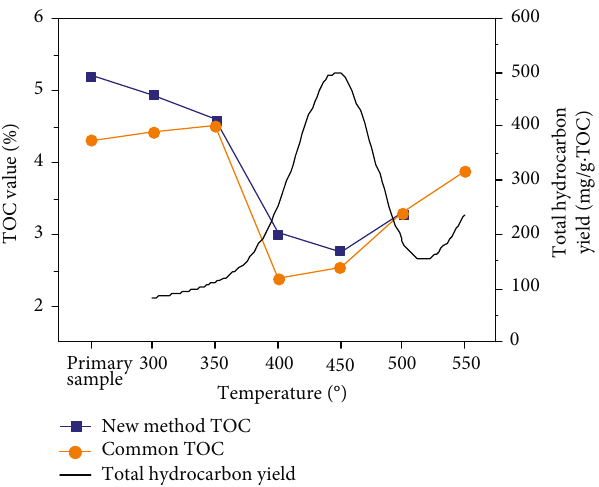
Figure 10: Yield of total hydrocarbon in a pyrolysis experiment and the TOC values of residue samples measured by two di ff erent TOC test methods. The sample was a low maturity carbonate collected from Cretaceous Eagle Ford Formation in Texas, USA, with the carbonate content of